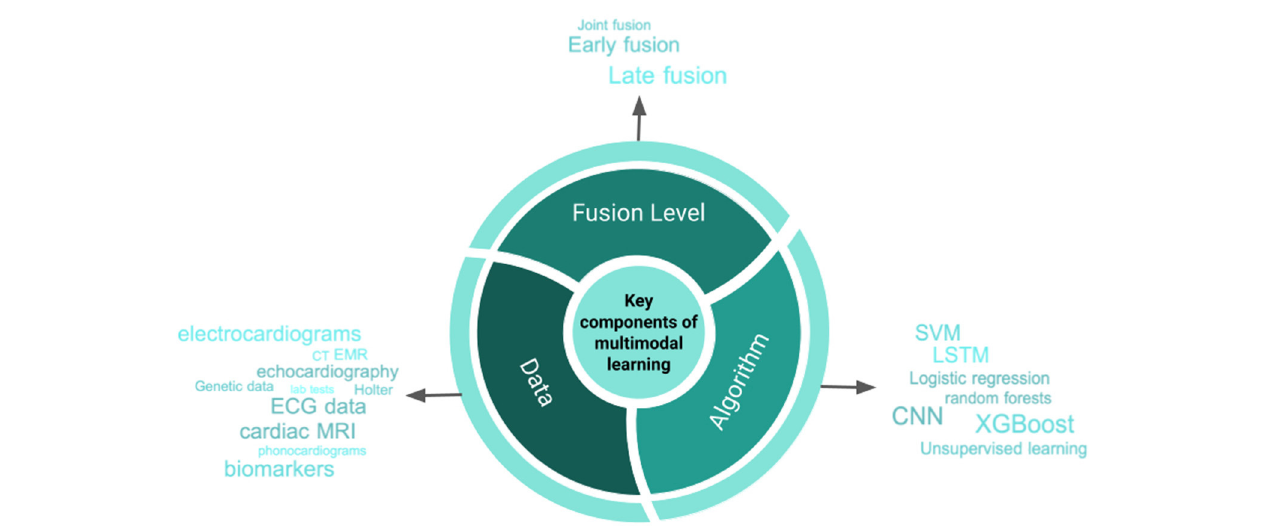
FIGURE 5 | Central Illustration. Important components of developing machine learning-based models using multiple data modalities. CNN, convolutional neural networks; LSTM, long short term memory; ECG, electrocardiogram; RBF, radial basis function; SVM, support vector machine; CT, computed tomography; MRI, magnetic resonance